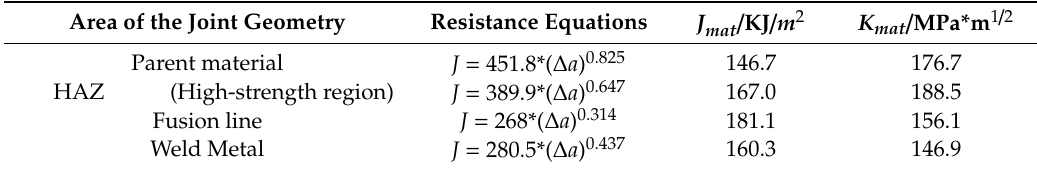
Table 9. The resistance equations and the J mat and K mat values of the undermatched welded joint after amending.